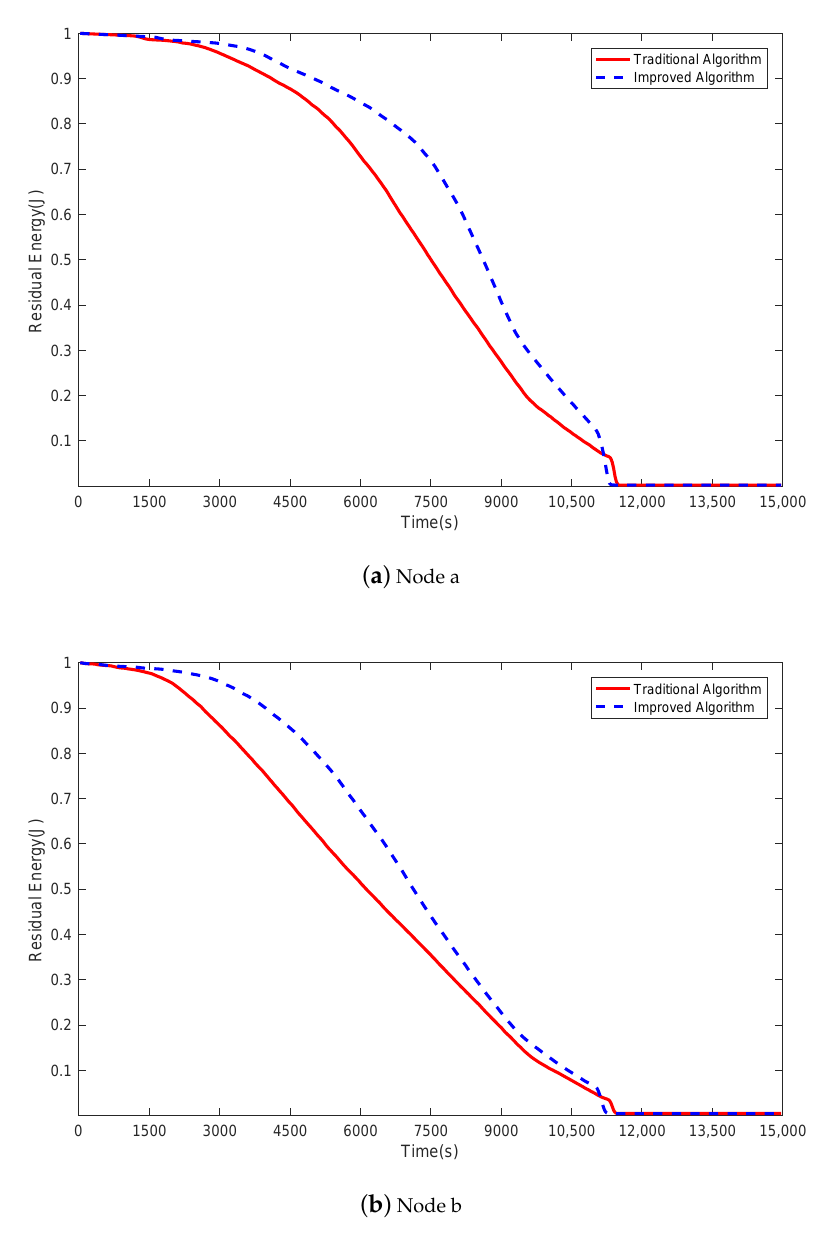
Figure 10. Comparison of energy consumption of malicious nodes a and b between the improved algorithm and the traditional